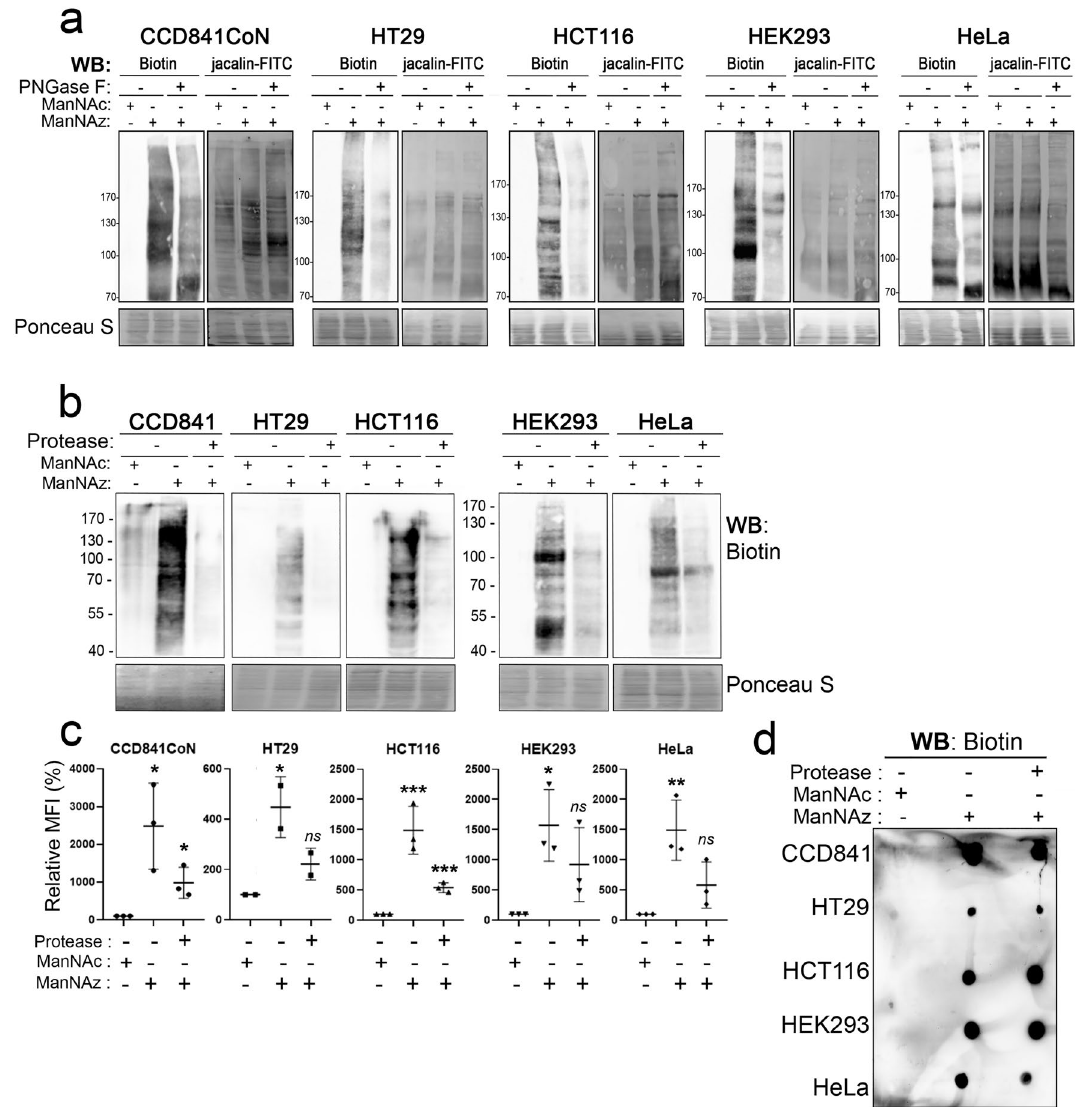
Figure 5. Sensitivity of labeling of glycoconjugates to PNGase F or protease treatment. Cells were incubated with 500 µM of either ManNAc (negative control) or ManNAz for 48 h before harvesting. a ) After CuAAC with the alkyne-biotin, cells were lyzed and 30 µg of proteins were incubated with or without PNGase F before Western blotting using anti-biotin-HRP or Jacalin-FITC. b – d ) Harvested cells were incubated for 15 min at 37 °C with or without the protease. Then CuAAC was performed onto cell pellets with either the alkyne-biotin probe ( b, d ) or the alkyne-AF488 probe for flow cytometry analysis ( c ). Labeled glycoproteins ( b ) or extracted gangliosides ( d ) were detected by Western blotting using anti-biotin-HRP. Results are representative of at least two experiments. *** p ≤ 0.005, ** p ≤ 0.01, * p ≤ 0.05; ns , non-significant (compared to the negative